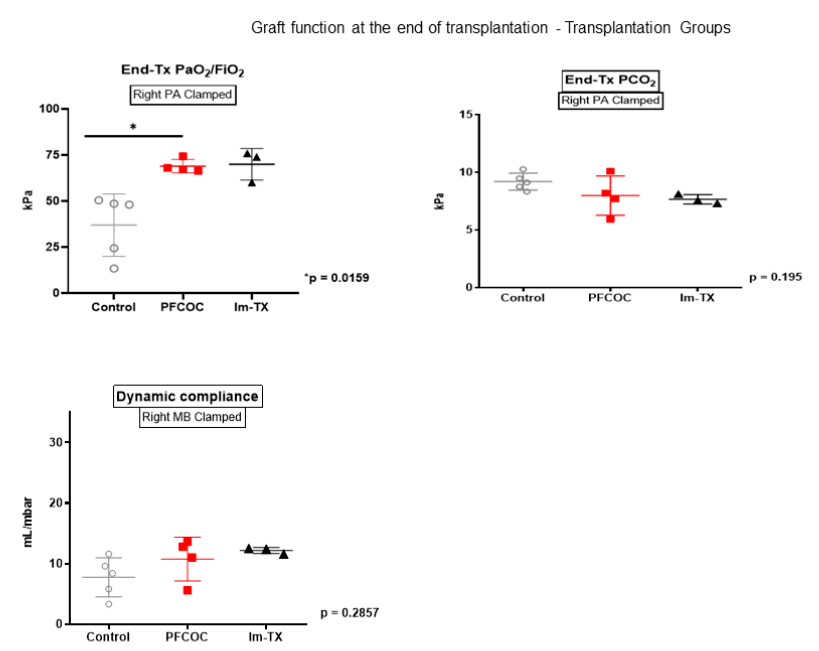
Figure 5. Graft function at the end of the 4 h reperfusion period. The Mann–Whitney test was used. Control: control group, PFCOC: perfluorocarbon-based oxygen carrier group. Im-Tx: Immediate transplantation group. The Im-Tx group was not included in the statistical analysis.